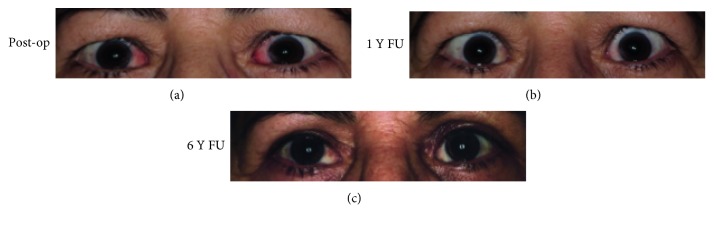
Patient 2 after surgery with Tutopatch (a) and 1 year later (b). (c) The same patient following lid surgery to correct her retraction of the upper eye lid.